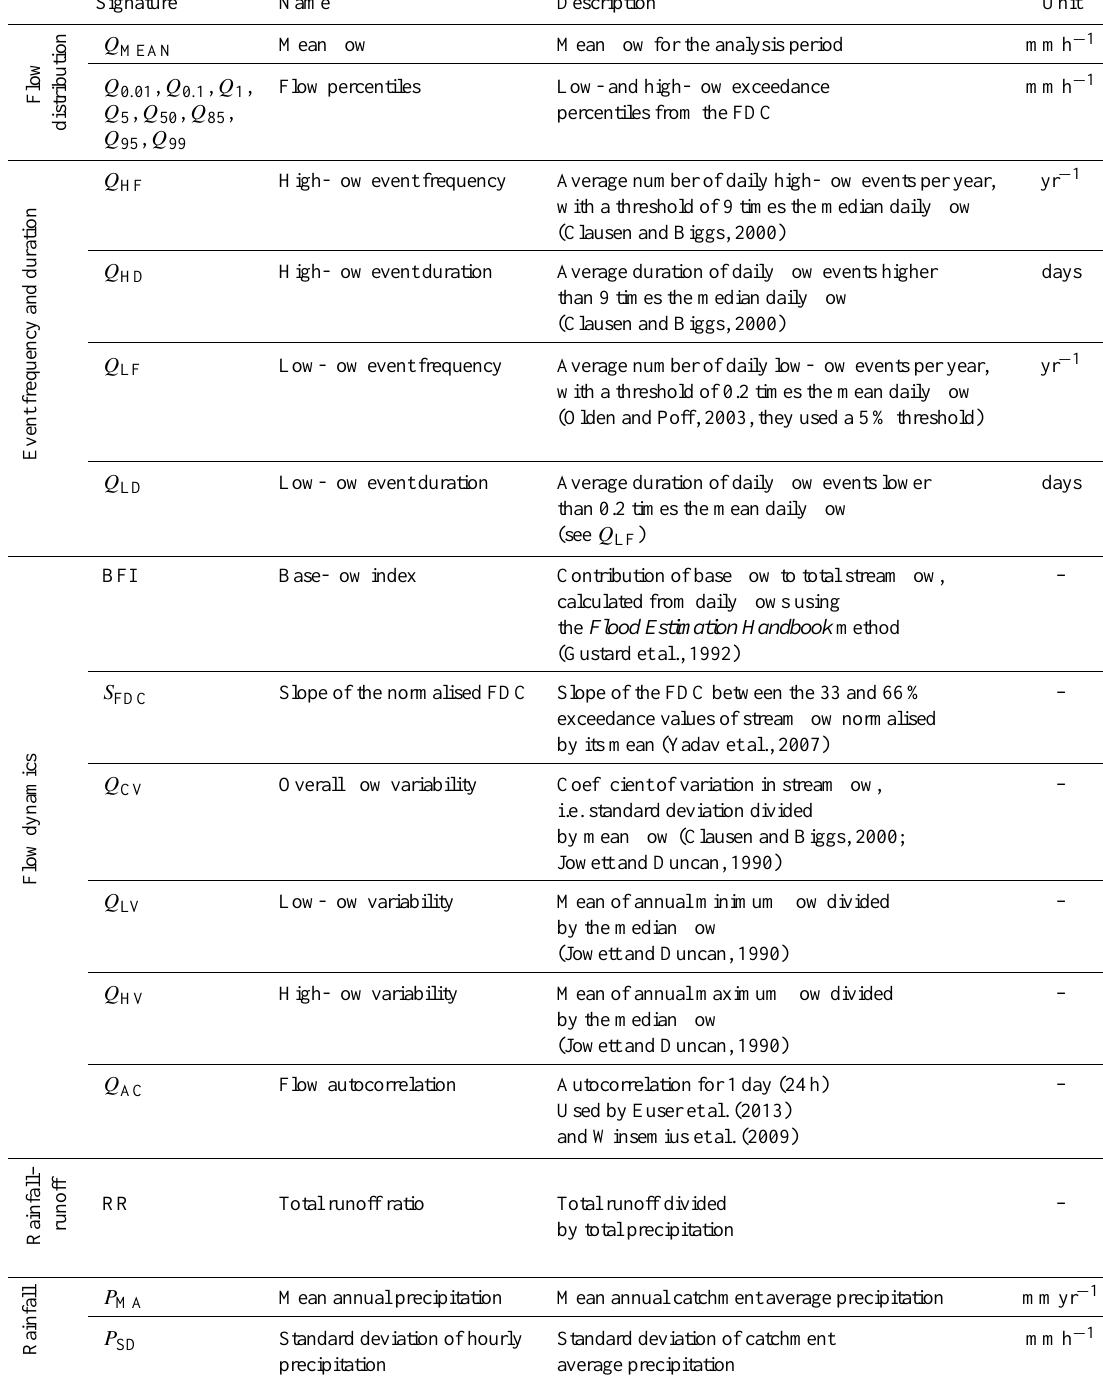
Table 2. Basic rainfall–runoff signatures included in the study. All signatures are calculated on hourly data unless otherwise